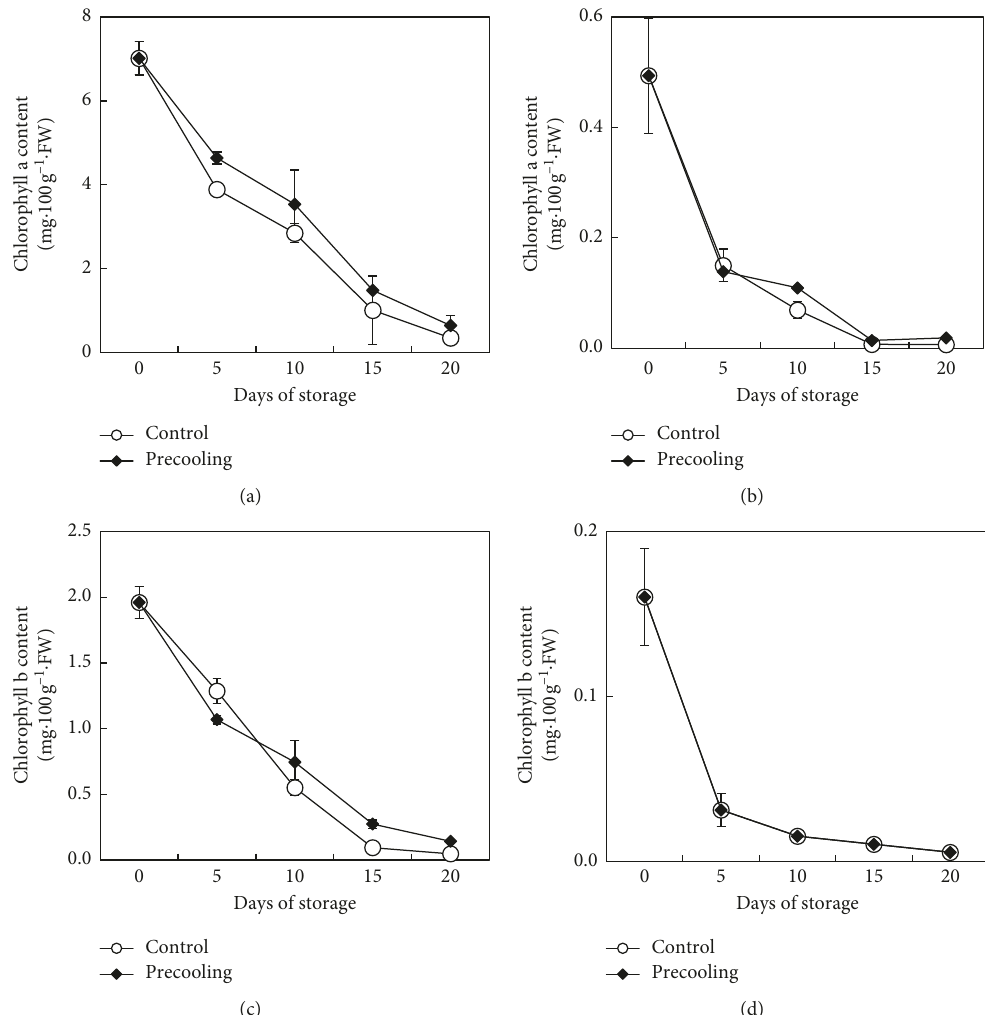
Figure 3: Effects of forced air precooling treatment on chlorophyll a of peel (a) and flesh (b) and chlorophyll b of mango fruit peel (c) and flesh